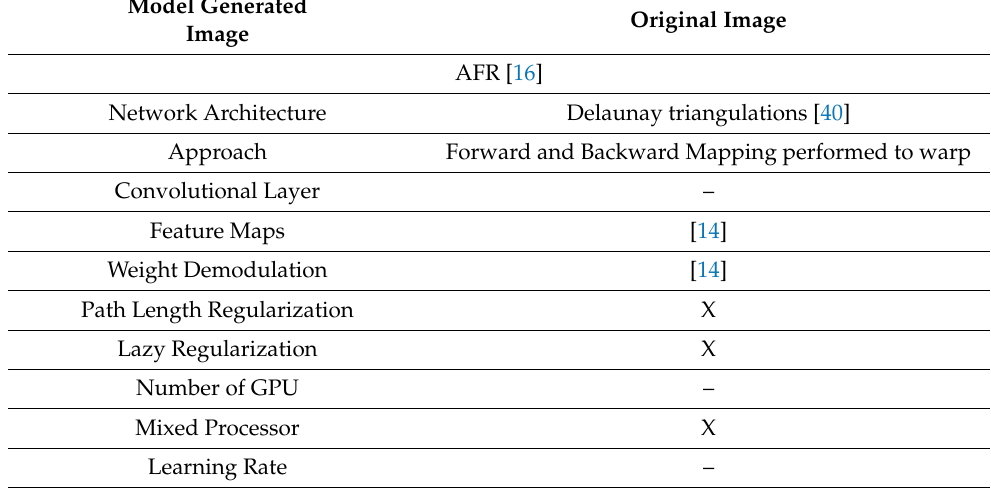
Table 7. Comparison with model [31] based on AFR